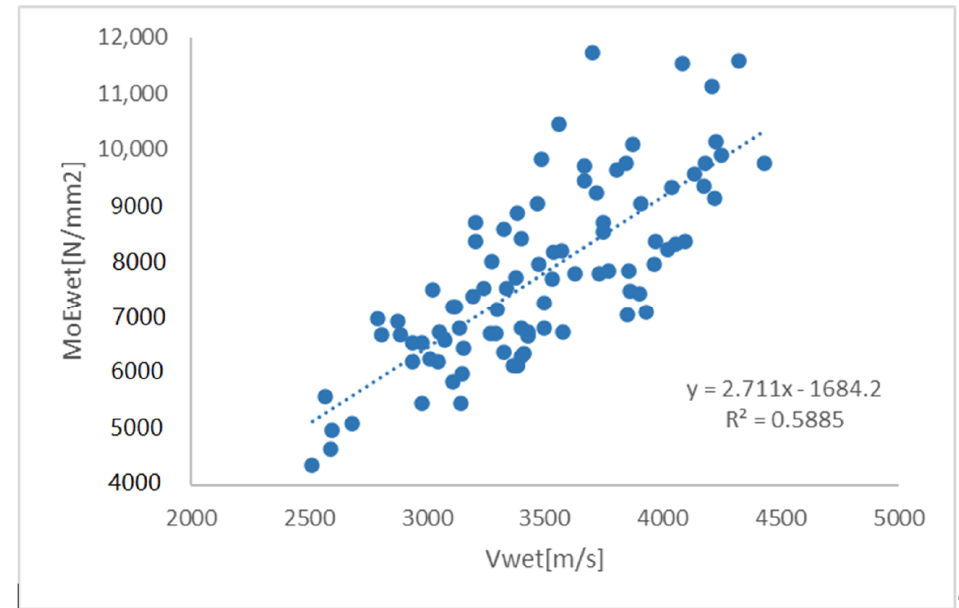
Figure 8. MoE dyn vs. wave velocity V—Wet condition.